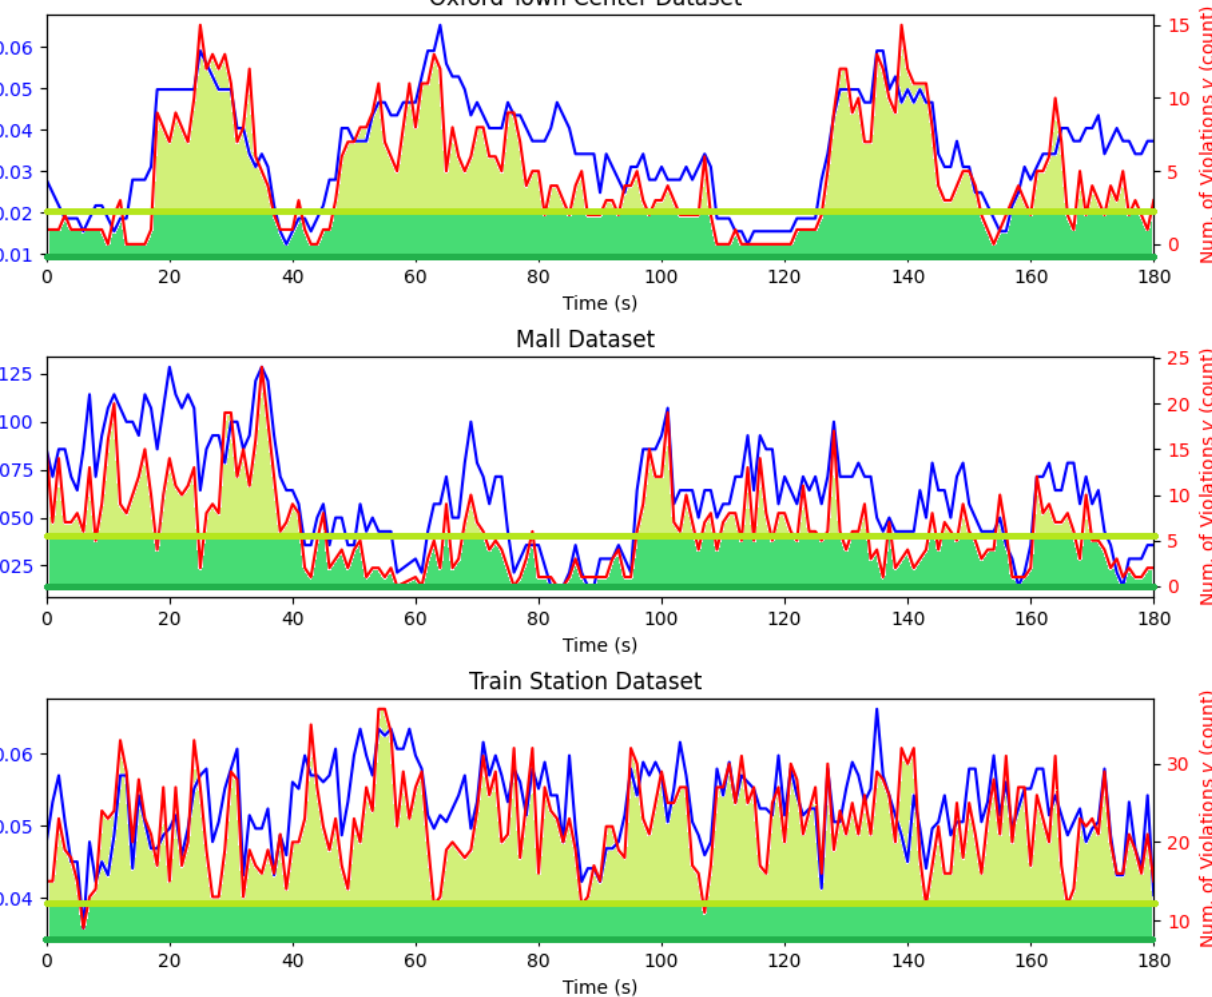
Figure 4. The change of pedestrian density ρ and the number of violations v over time. It shows an obvious positive correlation between ρ and v . The positive correlation is further illustrated in Figures 5 and 6, which show a linear relationship between ρ and v . The darker green horizontal line indicates the critical pedestrian density ρ c and the lighter green line, the intercept density β 0 . They are obtained by the proposed critical social density estimation methodology in Section 4.5. The shaded lighter green area shows that there will be more violations if the pedestrian density is above β 0 . The shaded darker green area shows that more violations will be eliminated if the pedestrian density is further pushed below ρ c , which is our critical social